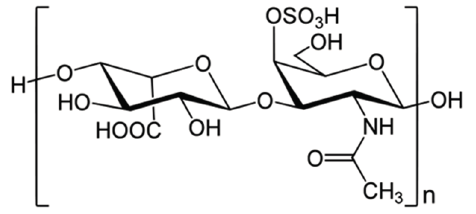
Figure 15. Dermatan sulfate ( 79 ), isolated from ascidian Styela plicata [102].